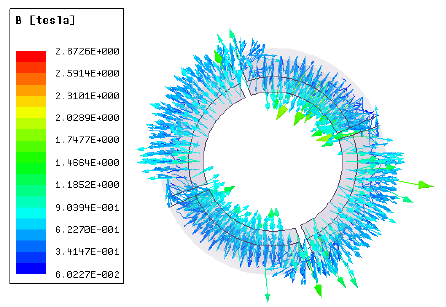
Figure 5. Pole magnetic field distribution of the generator.